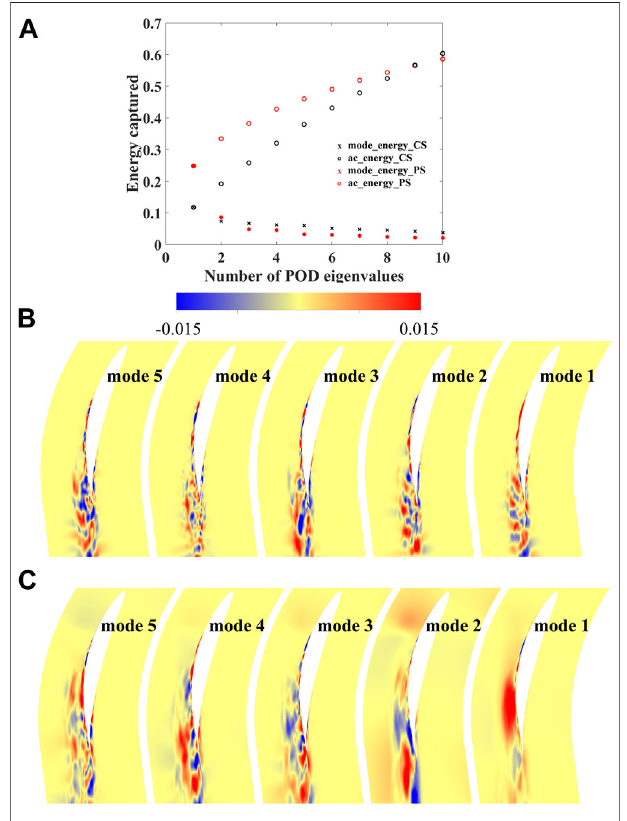
FIGURE 14 | Energy captured of the proper orthogonal decomposition (POD) modes and the contour map of the fi rst fi ve order modes. (A) Energy captured of the POD modes; (B) CS; (C) PS.